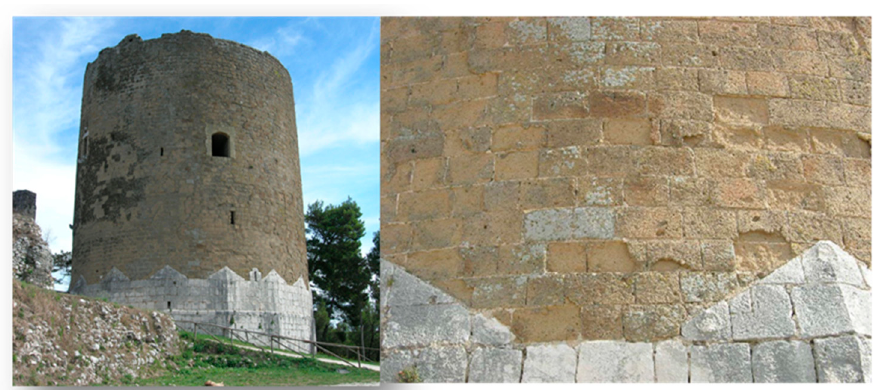
Figure 12. Example of the moderate physical weathering of facia vista Campanian Ignimbrite dimension stones (Mastio of the Caserta Vecchia Castle, Caserta Vecchia, left : whole building, right : physical weathering; picture by A. Langella).